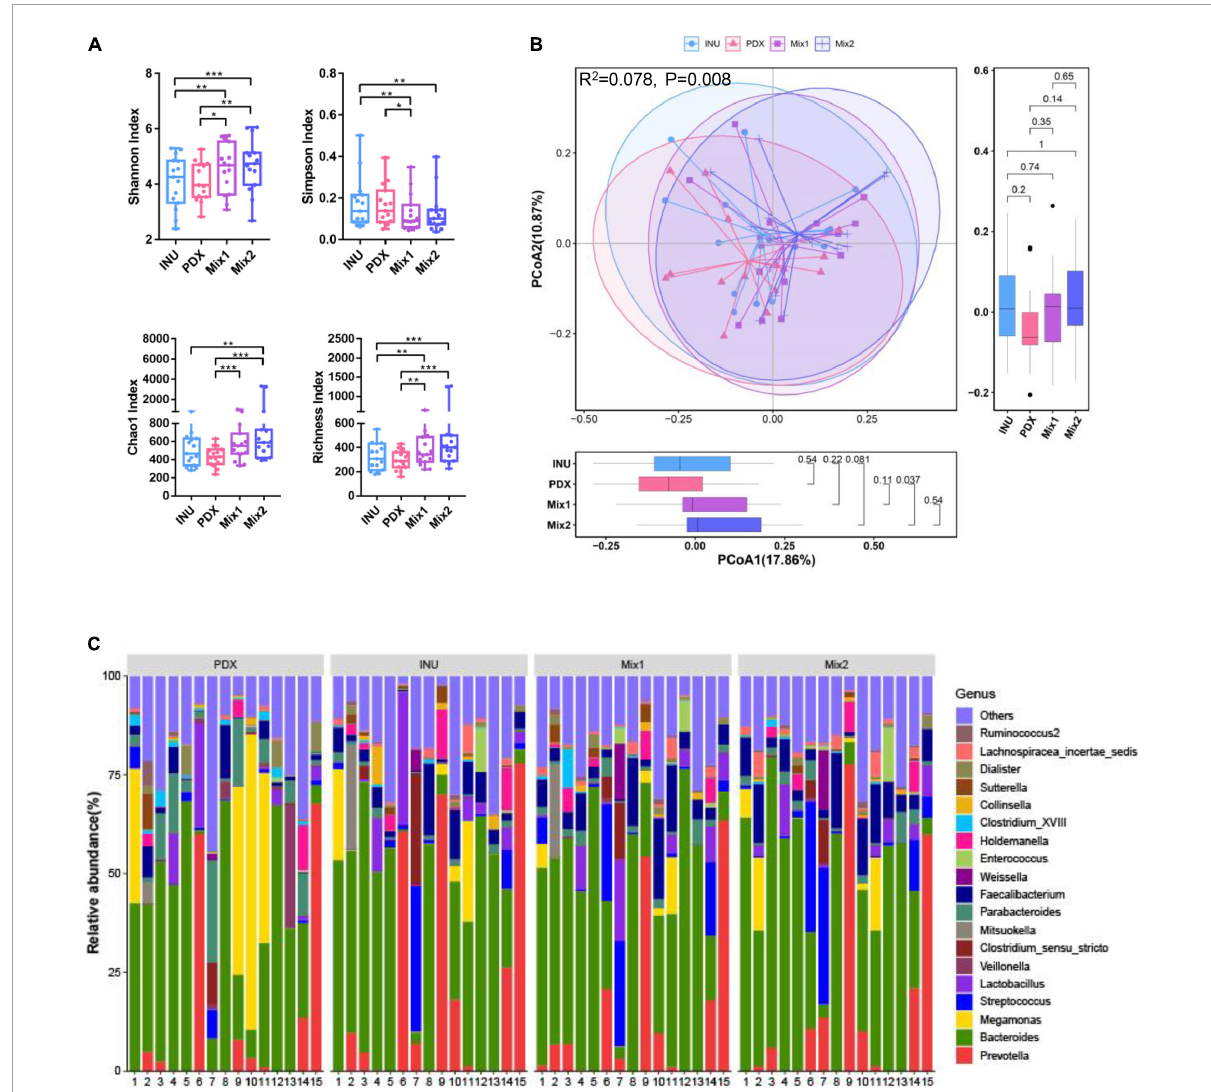
FIGURE4 Microbiota comparison of the fermentation broths of inulin, PDX, and their blends. (A) The alpha-diversity of the microbiota of the fermentation broths. (B) PCoA plot of the fermentation broths with Unifrac-binary distance and the p value was calculated by PERMANOVA. (C) The microbial composition of the fermentation broths at the genus level. * p value < 0.05, ** p value < 0.01, *** p value <